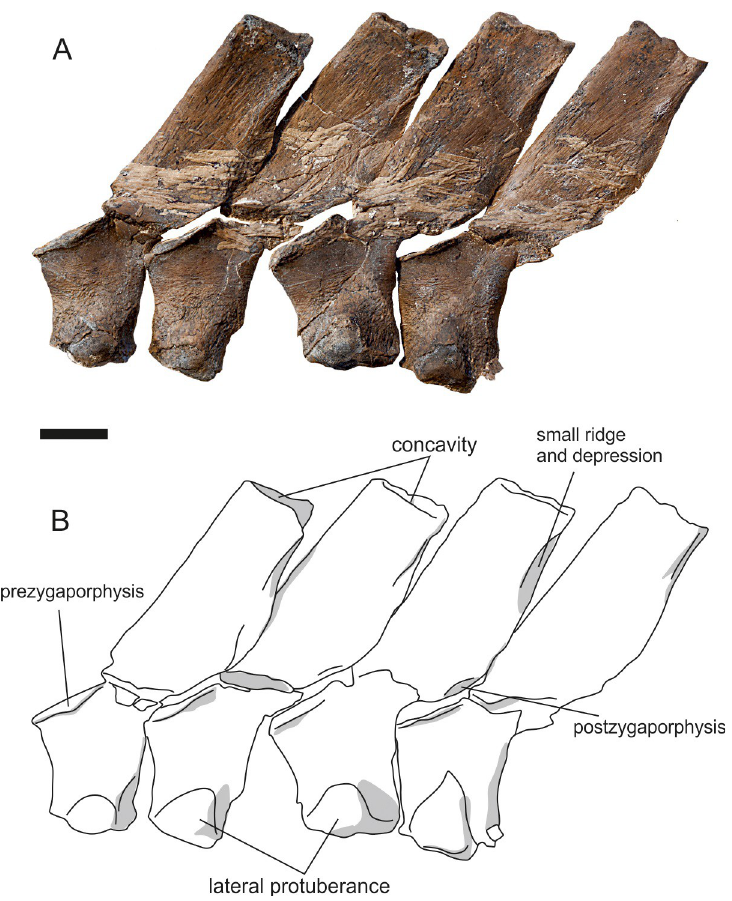
Fig 14. Neural spines of Thalassodraco etchesi , MJML K 1885. A, photograph of the neural spines. B, interpretive line drawing of the neural spines, highlighting the lateral protuberance on the neural arch. Scale bar 10 mm. reduces. The diapophyseal contribution is also reduced on the neural arches present on the isolated slabs (Fig 5). Rib cage. Dorsal ribs . On the main slab, there are 15 preserved articulated left dorsal ribs including and two cervical ribs articulating with the atlas-axis complex, 4 articulated right dorsal ribs and 3 disarticulated ribs. There are 12 dorsal ribs on the isolated slabs (Fig 5A–5D). The verte- bral column has been displaced dorsally during burial, such that the ribs no longer are in contact with the lateral processes of the vertebral centra. Ribs with little to no curvature preserved on slab B (Fig 5B) are most likely from the posterior thorax or caudal peduncle. The cervical ribs are short, 20mm and 40mm in length respectively, with an oval cross section. The cervical ribs are sin- gle headed, with the second cervical rib bearing a prominent dorsal notch. The cross section of the ribs are T-shaped proximally, turning into 8-shaped then oval and rounded distally. The ante- rior dorsal ribs are deep, approximately 13 times as long as the height of the vertebral centra. Gastralia. Many gastralia are preserved on all four slabs but are displaced and disarticu- lated. They are thin, slender, rod–like at one end and expand at the opposite end (Fig 5). Appendicular skeleton. Pectoral girdle . The pectoral girdle is complete and articulated, with only a slight taphonomic offset of the interclavicle with the coracoids. The left scapula, distal end of the left clavicle and part of the anteromedial process of the right coracoid are